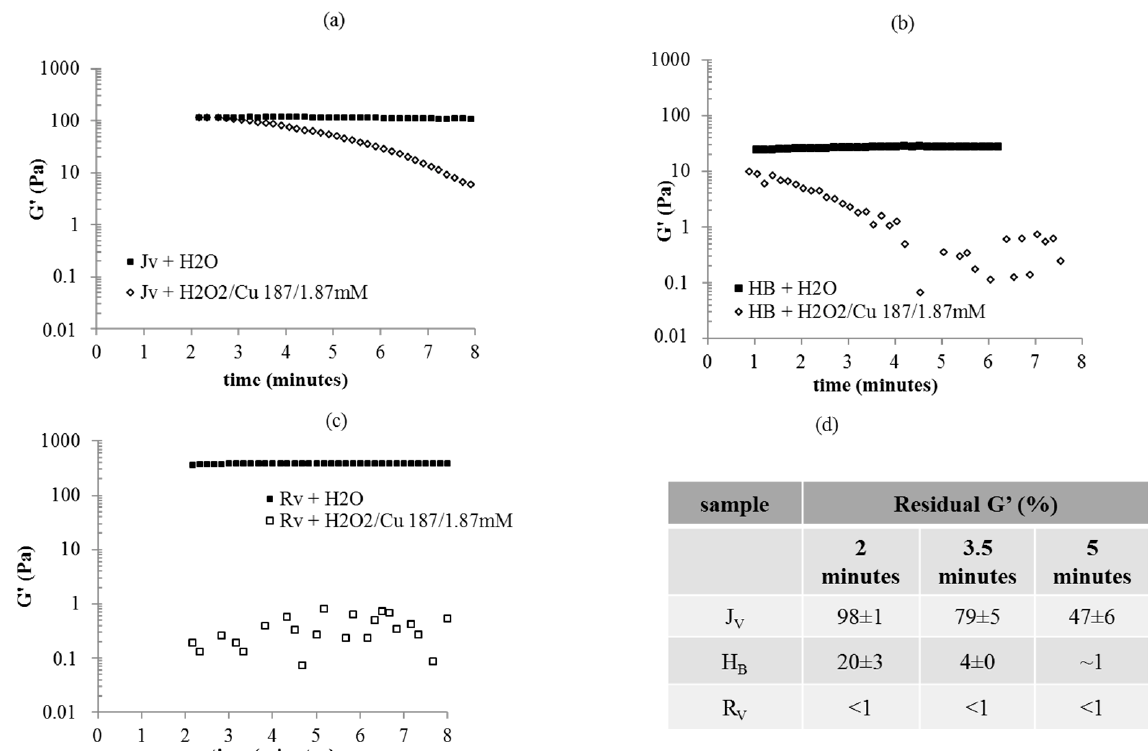
Figure 3. Degradation in the presence of ROS. G’ values during incubation with H 2 O 2 /Cu 2+ 375/3.75 mM, compared to a control (gel diluted to the same extent with water) for J v ( a ), H B ( b ) and R v ( c ). Measurements were performed at 37 ◦ C, 1.59 Hz frequency and 0.1% strain. ( d ) Residual G’ (% in respect to G’ for the control) at 2, 3.5 and 5 min of incubation with